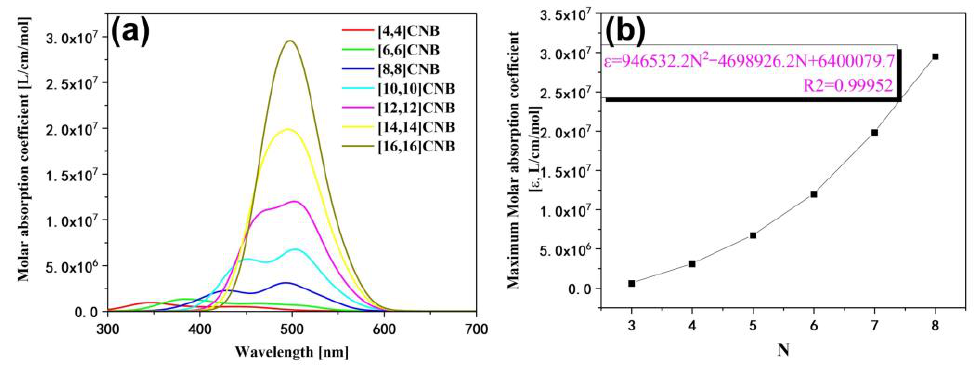
Figure 6. ( a ) TPA spectrum of [2N,2N]CNB. The absorption peak of the absorption spectrum is broadened by a Gaussian function, FWHM = 0.5 eV. ( b ) The relationship between the ε of the maximum absorption peaks of [2N,2N]CNB and the